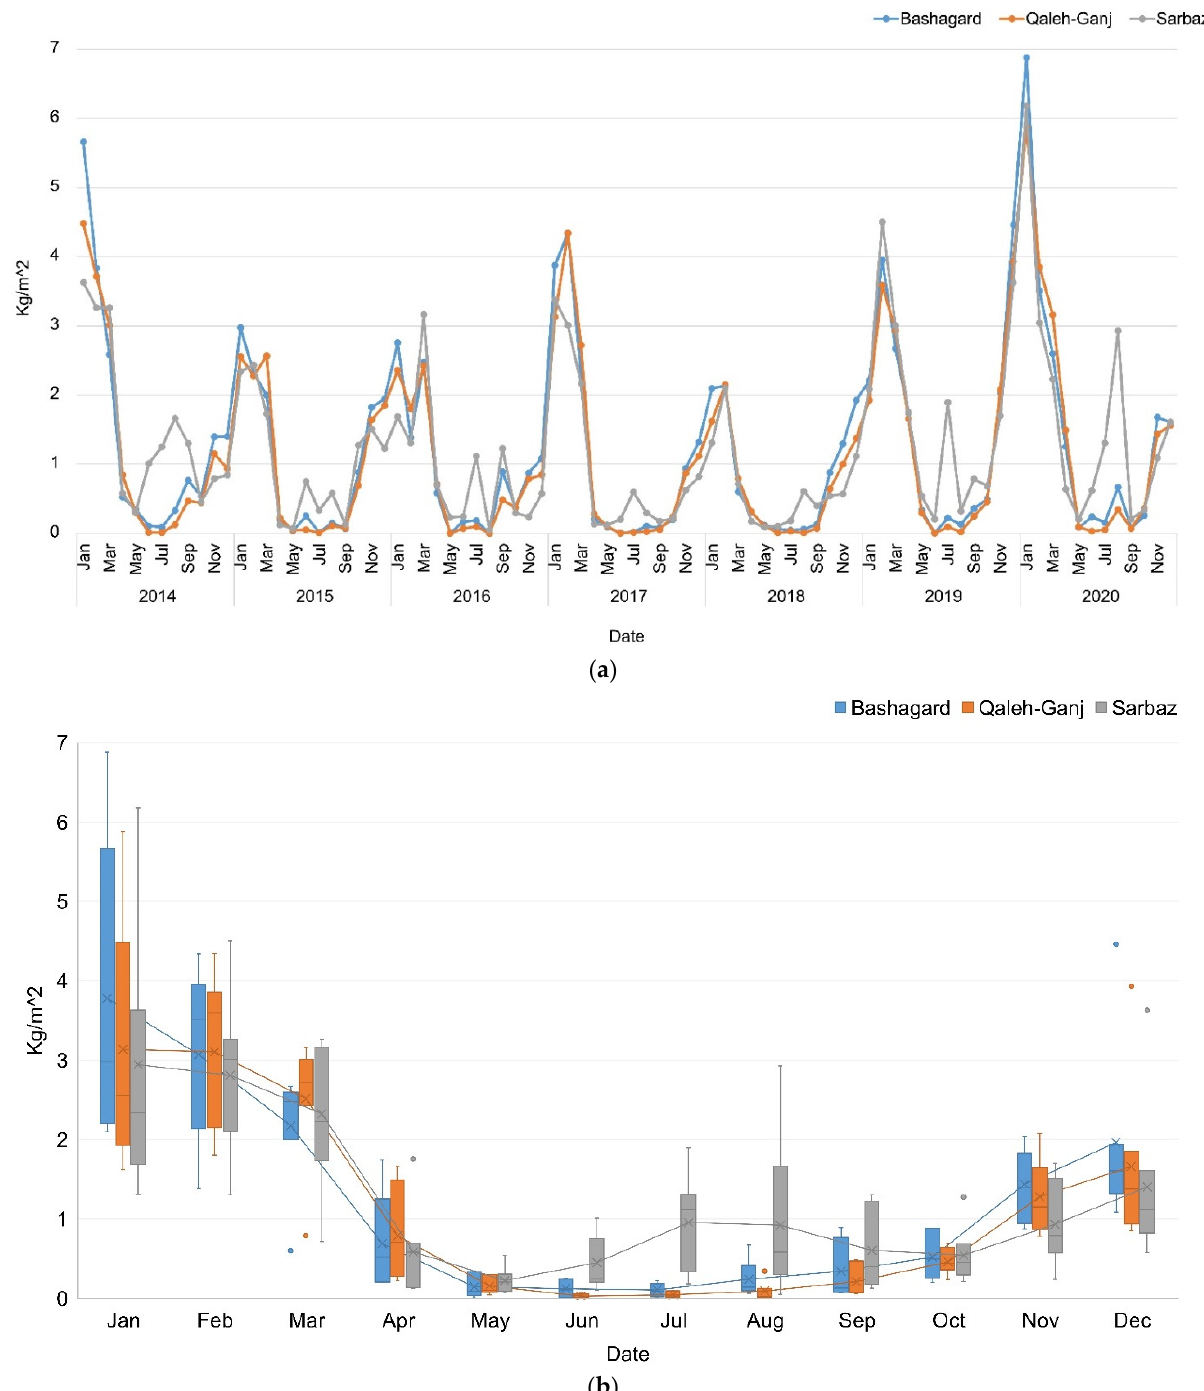
Figure 8. ( a ) ET time series; ( b ) Box plot of ET time series of Qaleh-Ganj, Sarbaz and Bashagard counties, Iran,